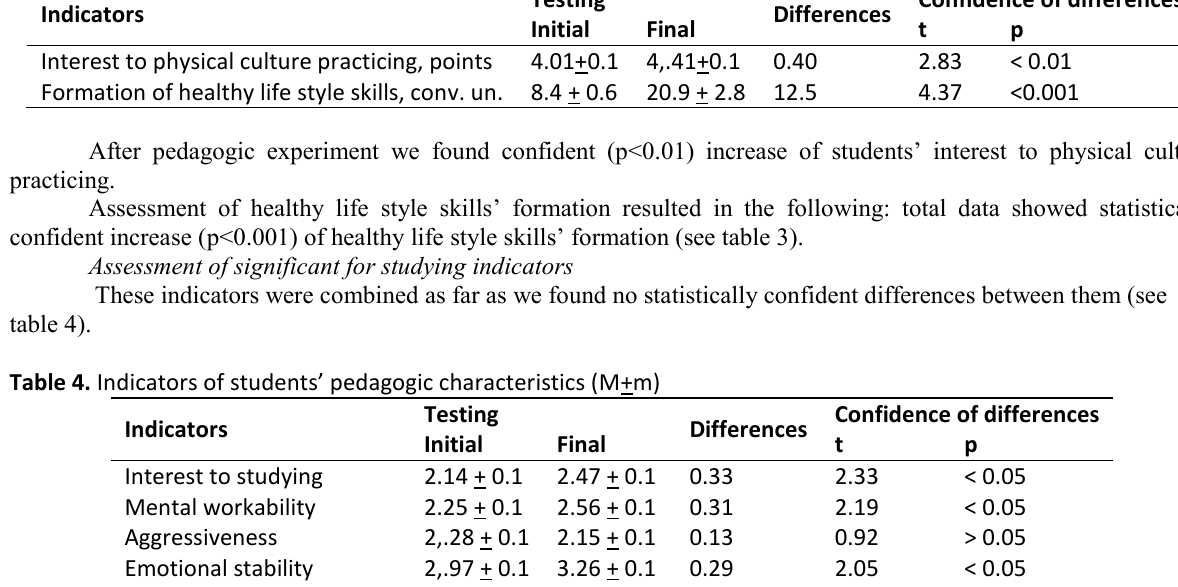
Table 3. Indicators of students’ interest to physical culture practicing and formation of healthy life style skills (points) (M+m) Indicators Interest to physical culture practicing, points